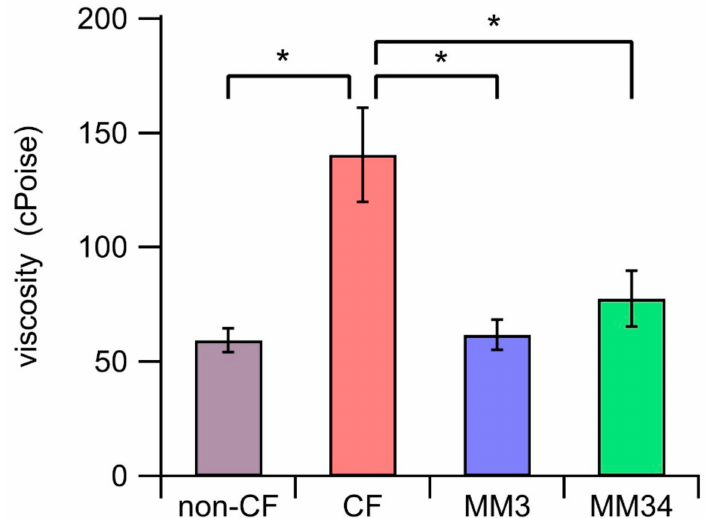
Figure 6. Mucus viscosity. Bars represent the average viscosity after 24 h of incubation. Untreated CF ( n = 8) and non-CF ( n = 6) epithelia were incubated with 0.1% DMSO as control. CF epithelia were incubated with 0.25 µ M of MM3 ( n = 7) or 0.25 µ M of MM34 ( n = 8). Data were obtained from two non-CF donors and two di ff erent homozygous F508del-CFTR patients. The asterisk (*) indicates a significant di ff erence ( p < 0.05) obtained from a Student’s non-paired- t